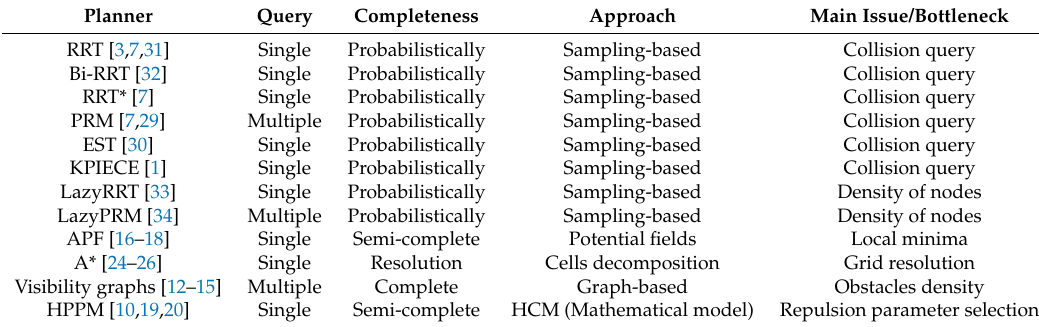
Table 1. Main characteristics of collision-free path planners.